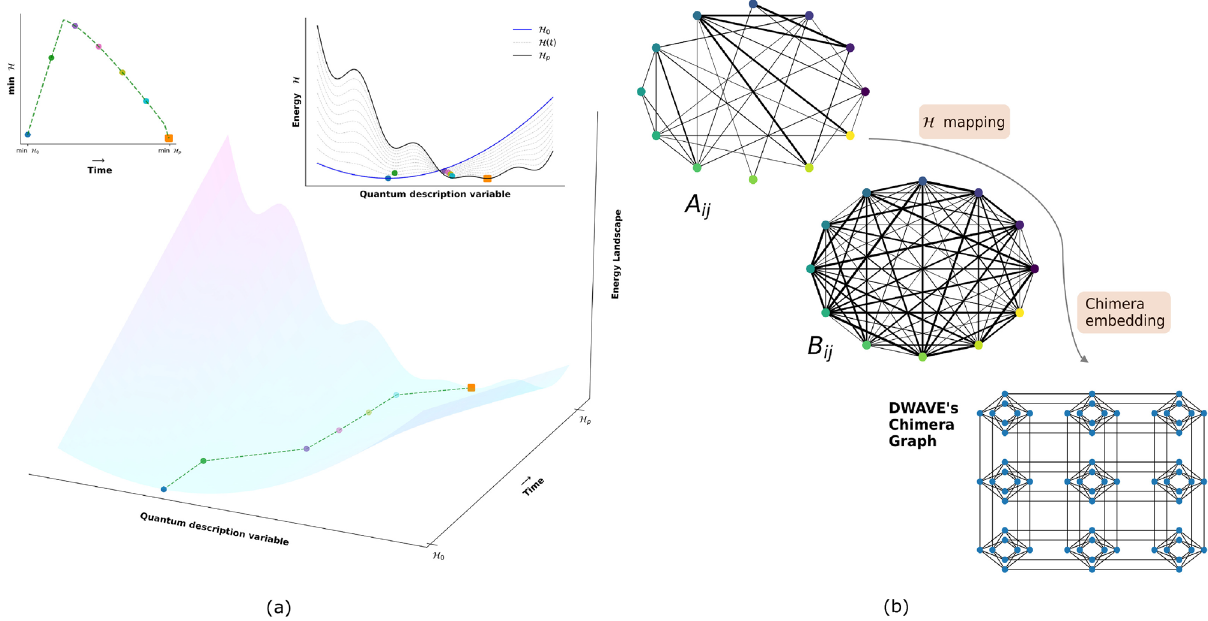
Figure 1. Simplified description of a Quantum Annealing (QA) process in ( a ). Initially, the system is prepared in the ground state of an “easy” hamiltonian H 0 (solid blue line), in this case a simple cuadratic function of a variable describing the quantum state. The hamiltonian of the system, as in Eq. (11), is let to evolve adiabatically (dashed grey lines) resting at the minimum of each intermediate hamiltonian H ( t ) (coloured circles). Under these conditions, the final state, depicted as the big orange square, will correspond to the ground state of the desired system H p (solid black line). Note that the two discrete jumps (green-purple and cyan-orange) are possible thanks to quantum tunneling. In ( b ), schematic representation of the logical process explained in the Methods. To partition a graph via QA, the connections of the original network, given by an adjaceny matrix as in Eq. (1), need to be mapped to a fully connected Ising-like system of spins. Note that the dimensions of the Ising system are the same as the original network (identical node coloring) but the strengths of the connections (solid weighted black lines) are now given by the modularity matrix in Eq. (7). The system is then embedded in a Chimera graph 20 (i.e., the quantum processor) by using the D-Wave platform. Each node in the Chimera graph represents a